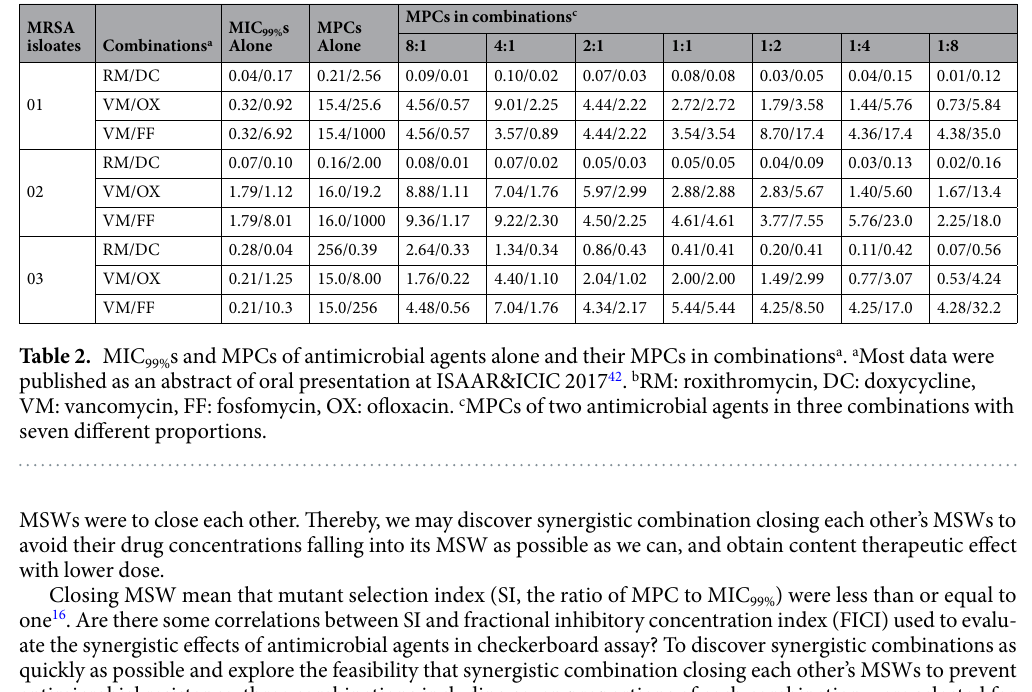
antimicrobial resistance, three combinations including seven proportions of each combination were selected for clarifying the correlations between SI and FICI. Results